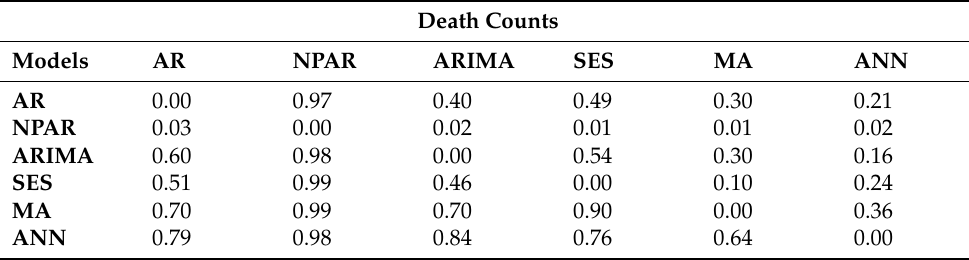
Table 6. Results ( p -value) of the DM test for all the considered models using the death counts. Death